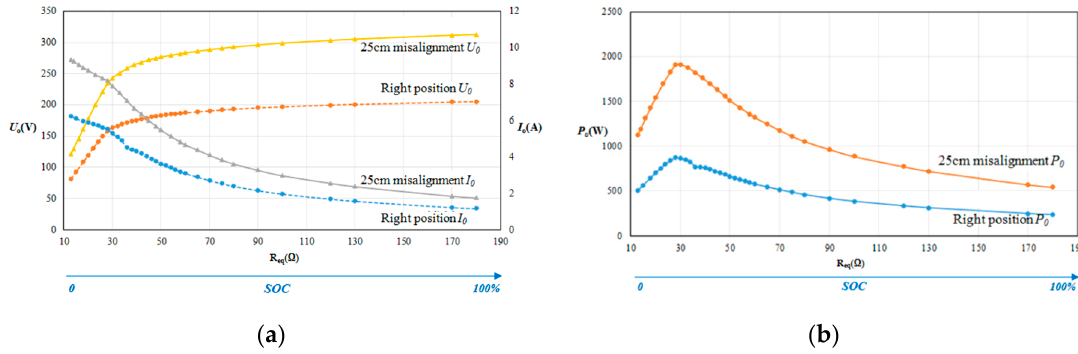
Figure 26. Variation with equivalent resistance at different displacements in y axis: ( a ) output voltage and current; ( b ) system output power.